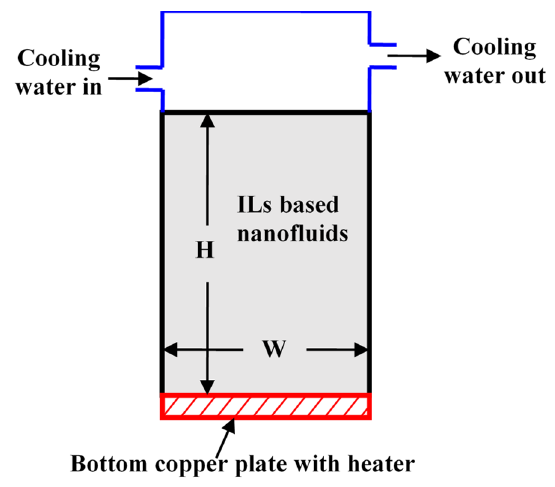
Figure 20. Schematic of experimental cavity [84]. Reproduced with permission from [Paul], [Int. J. Heat Mass Transf.]; published by [Elsevier], 2015.